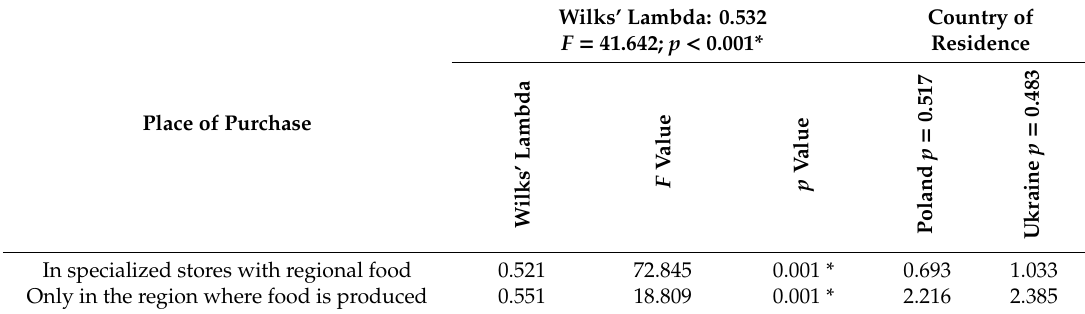
Table 5. Places for purchasing regional food